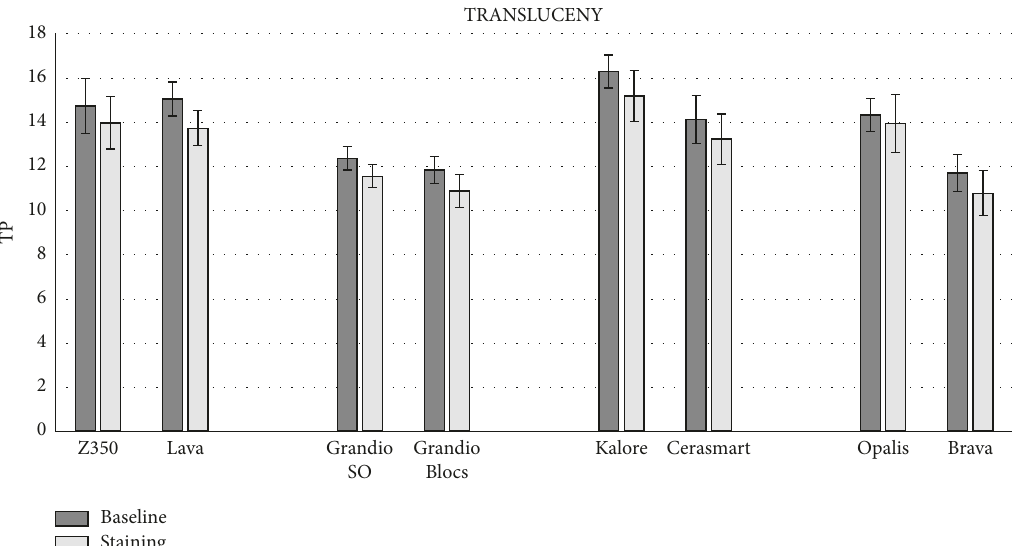
Figure 2: Means (SD) of translucency (TP) for all groups before and after staining.